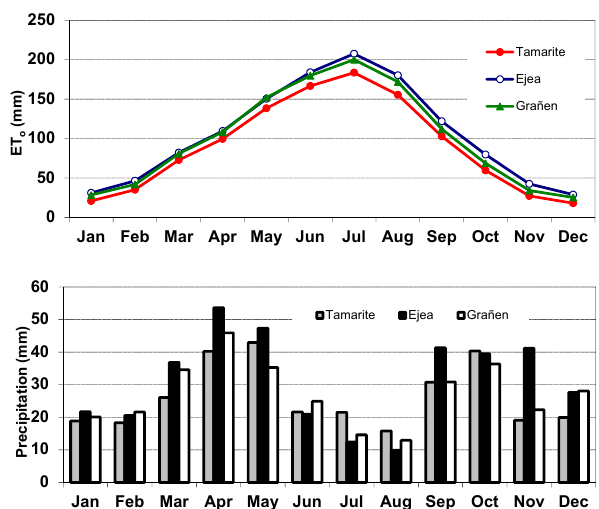
Fig. 3. Long-term monthly averages of ET o (mm) and precipitation (mm) during the period analysed (2004–2011) in the irrigation dis- tricts of Riegos del Alto Arag´on (weather station, Gra˜n´en), Canal de Bardenas (weather station, Ejea) and Canal de Arag´on y Catalu˜na (weather station,